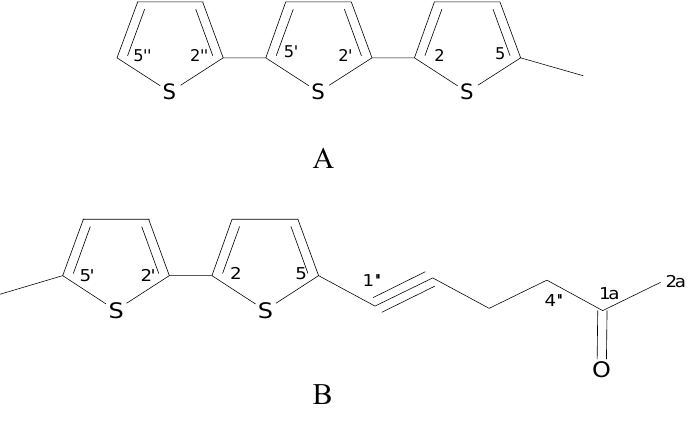
Figure 1. Structures of the thiophene derivatives isolated from P. ruderale ( A )